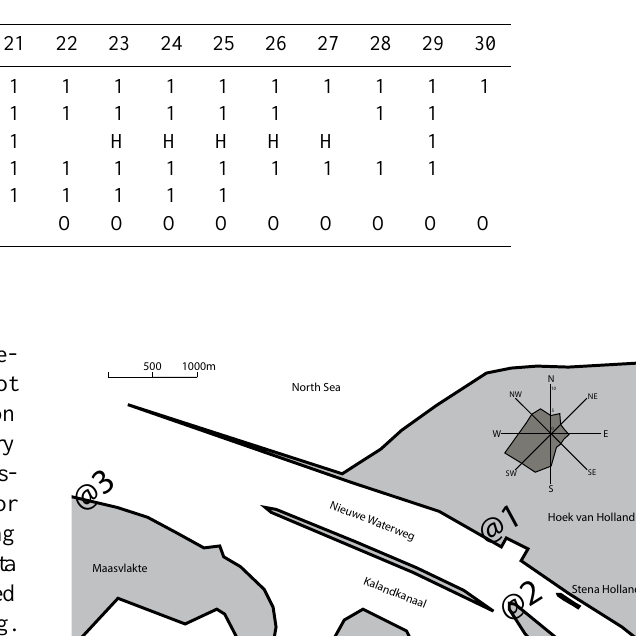
Table 1. Overview of the measurements, performed in September 2009 during the SIRENAS-R campaign. The table shows the location of the different research groups and their instruments during the measurement days (1: Hoek van Holland, 2: Landtong, 3: Maasvlakte, S: Fire-brigade Ship, H: Helicopter, O: Onboard Stena Hollandica ).